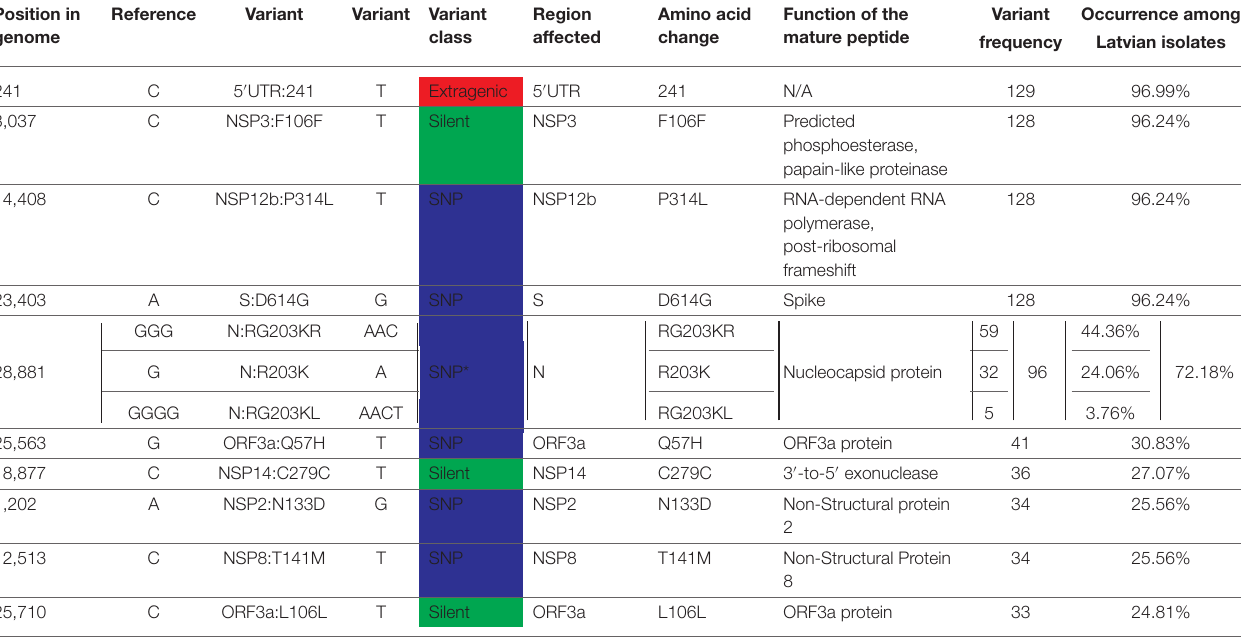
TABLE 2 | Ten most frequently mutated genome positions among Latvian SARS-CoV-2 isolates ( n = 133). Position in